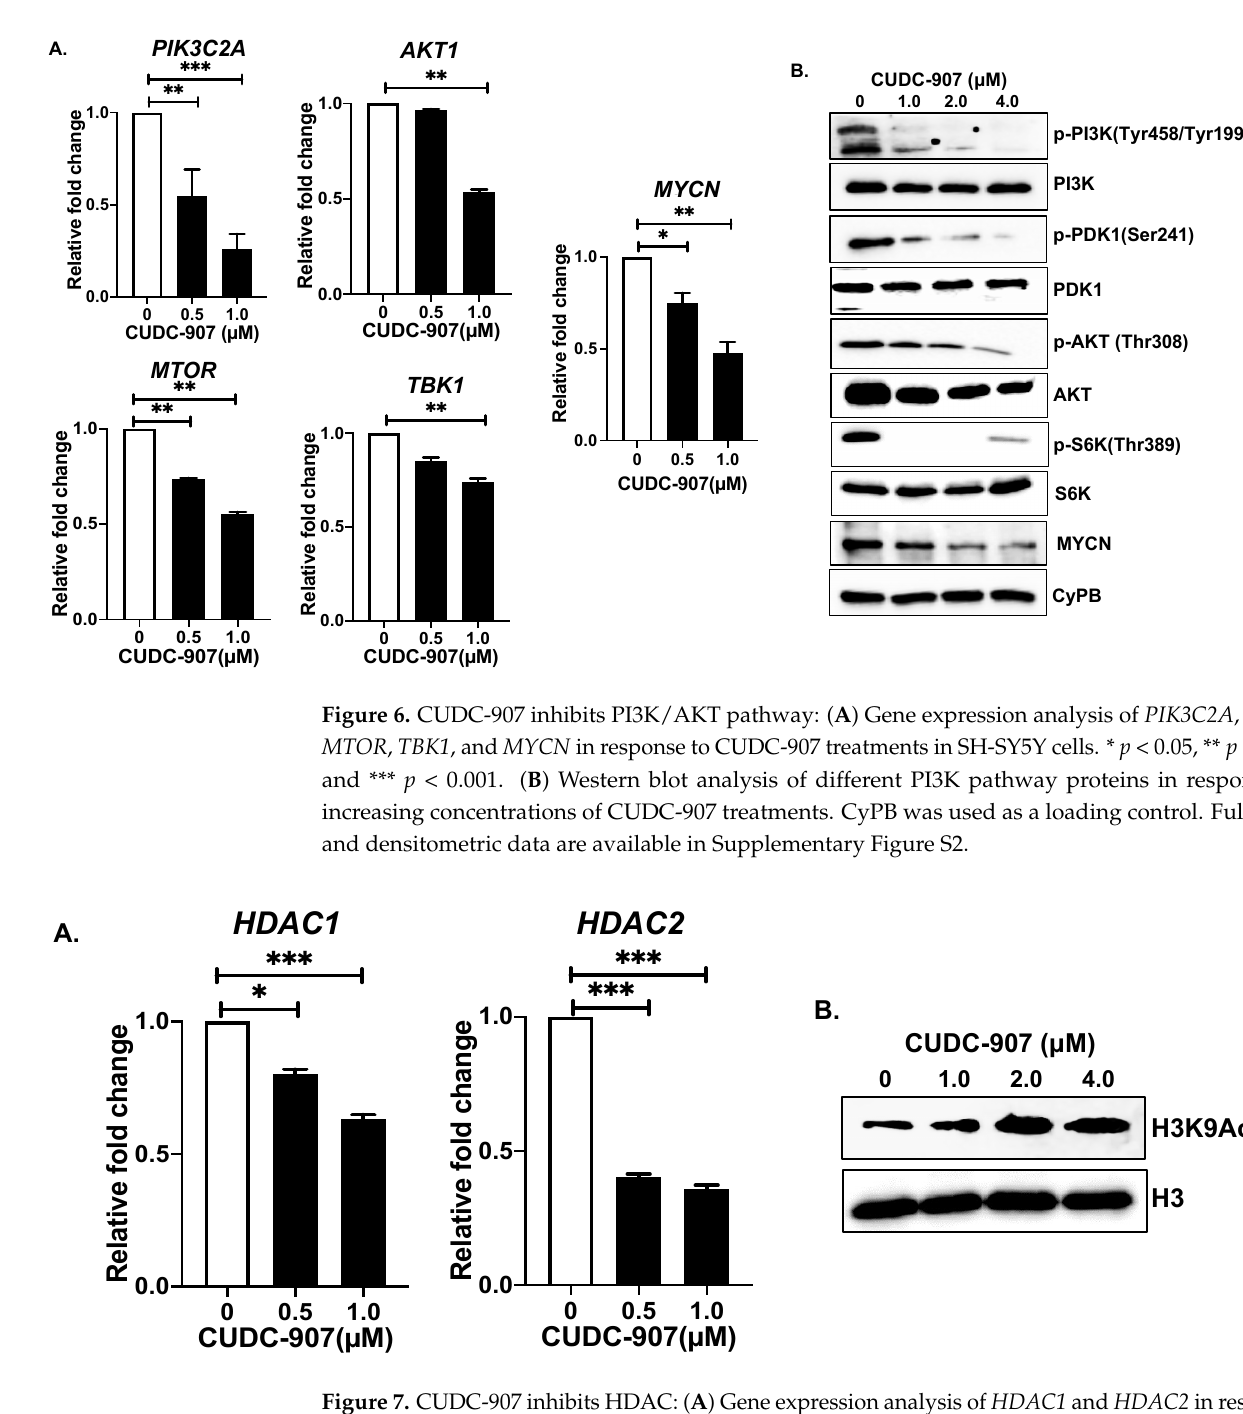
Figure 7. CUDC-907 inhibits HDAC: ( A ) Gene expression analysis of HDAC1 and HDAC2 in response to CUDC-907 treatments in SH-SY5Y cells. * p < 0.05, *** p < 0.001. ( B ) Western blot analysis of H3K9Ac and total H3 in response to increasing concentrations of CUDC-907 treatments. H3 was used as a loading control. Full blots and densitometric data are available in Supplementary Figure